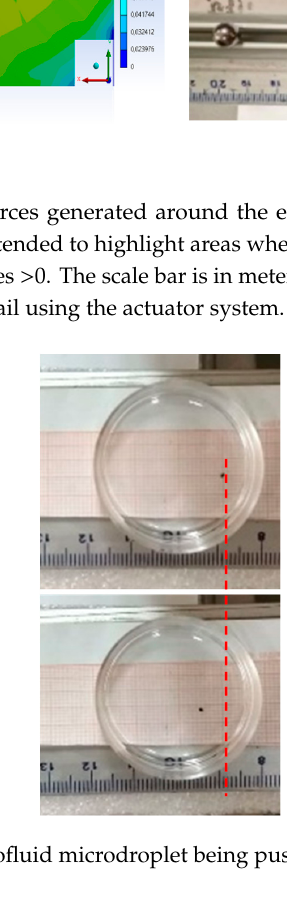
Figure 3. ( a ) Map of magnetic forces generated around the electromagnets; units reported in the simulation are arbitrary and are intended to highlight areas where the force is almost zero (dark blue), while the other colors indicate forces >0. The scale bar is in meters. ( b ) A paramagnetic sphere pushed from 9 to 19 cm on an aluminum rail using the actuator system.